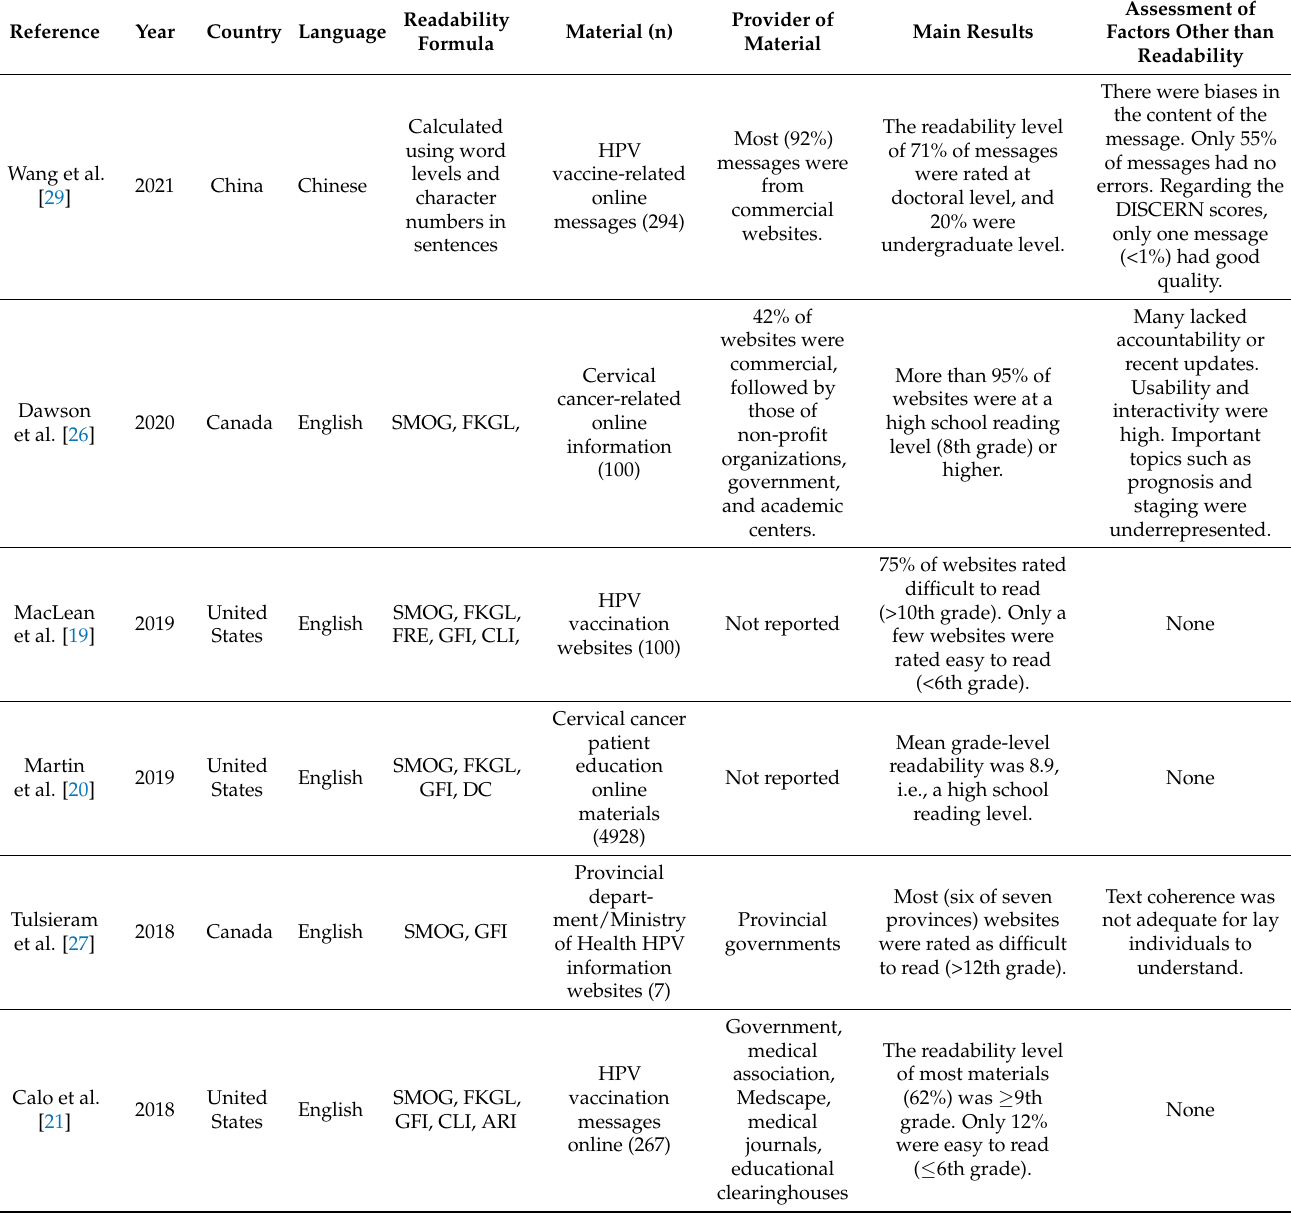
Table 1. Studies assessing readability level of HPV vaccination and cervical cancer-related